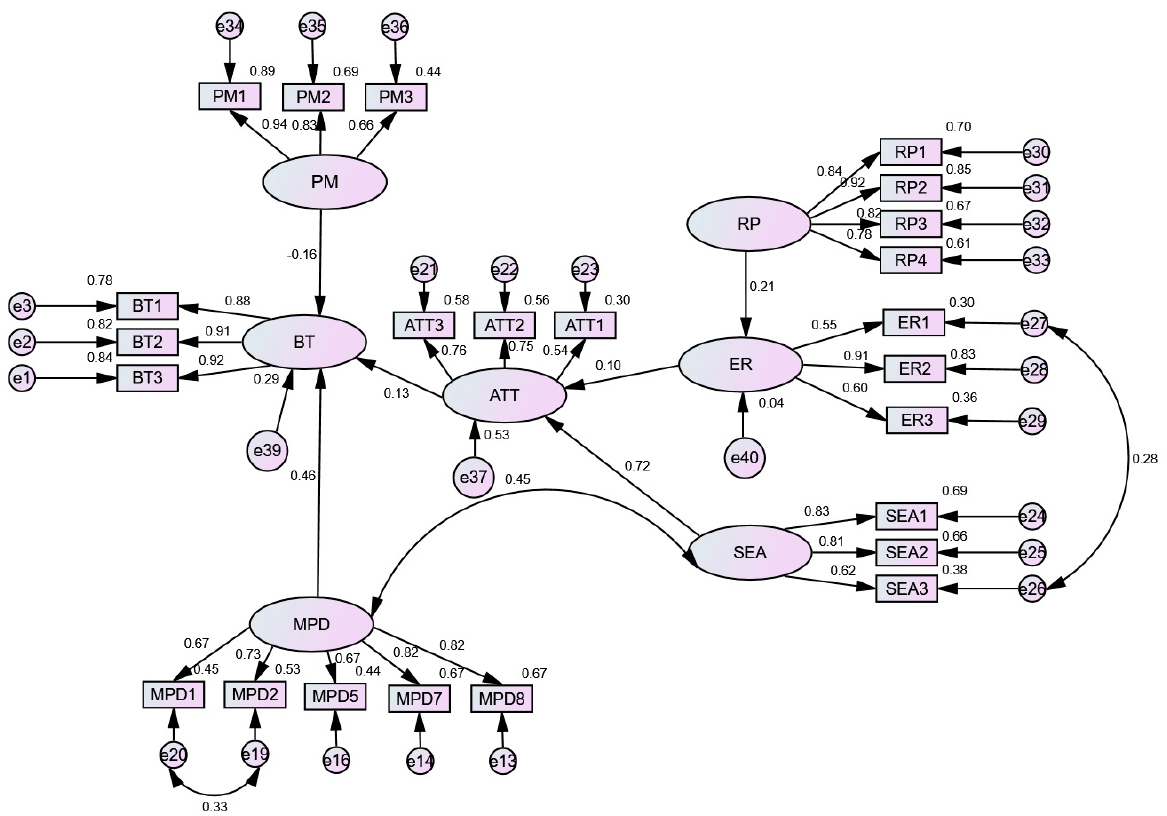
Figure 2. Analysis results of the causes of mobile phone use in riding (Model 2).